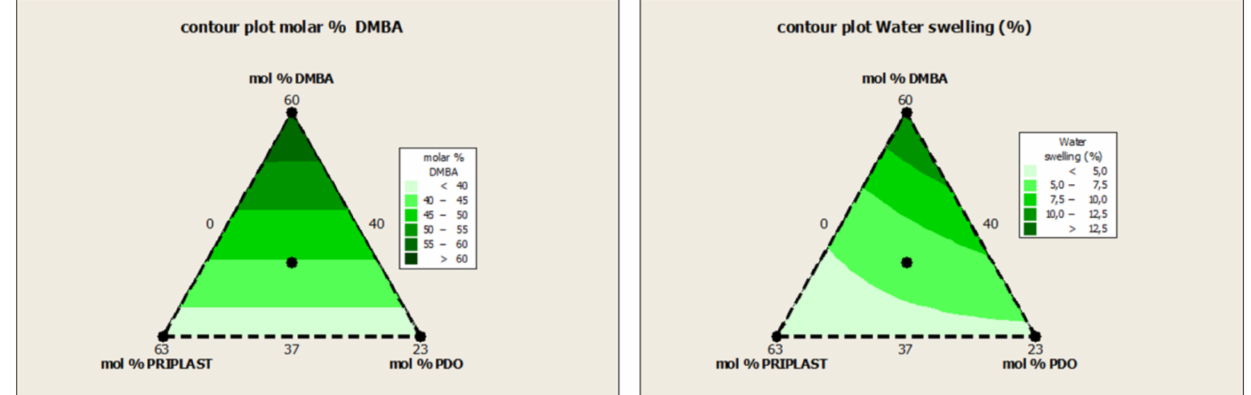
Figure 16. Contour plot of molar % of DMBA ( left ) and Water swelling ( right ) of all the WPUD films from de ternary mixture experimental design.